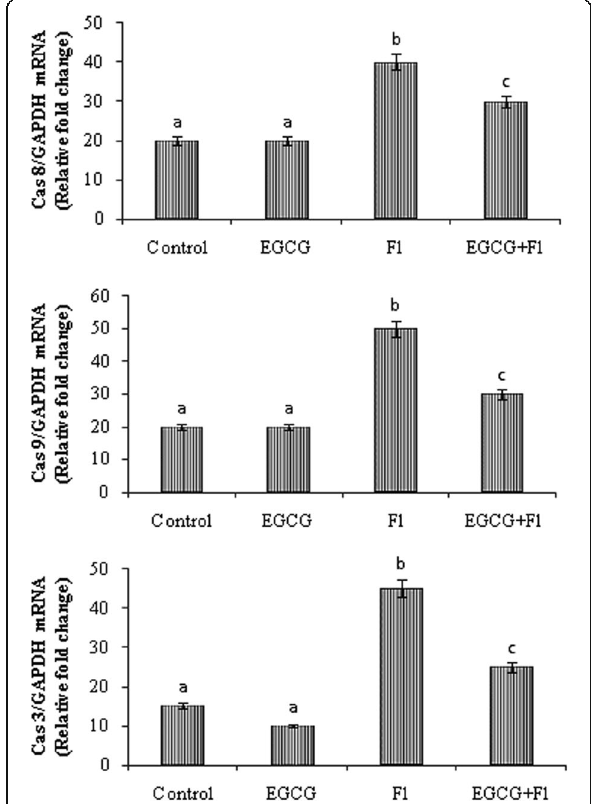
Fig. 10 Effect of EGCG on Caspases 8, 9, and 3 mRNA expression in the hippocampus of control and experimental rats. Values are mean ± SD for 6 rats in each group. a, b, c Values not sharing a common superscript letter (a, b, and c) differ significantly at p < 0.05